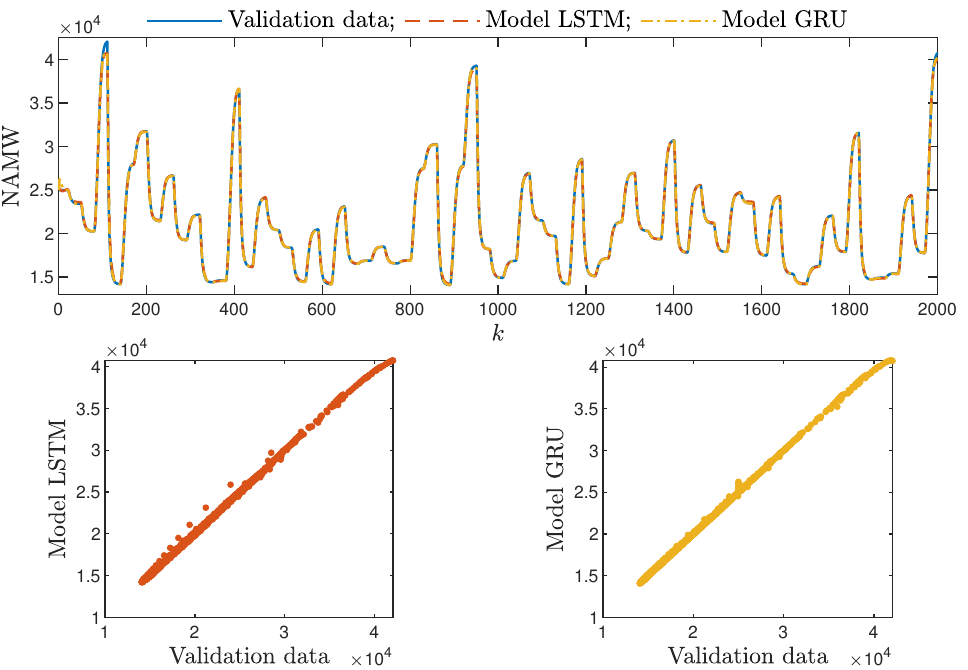
Figure 10. The polymerisation reactor: the validation dataset vs. the output of the LSTM and GRU models for n N = 9, n A = 0, n B =